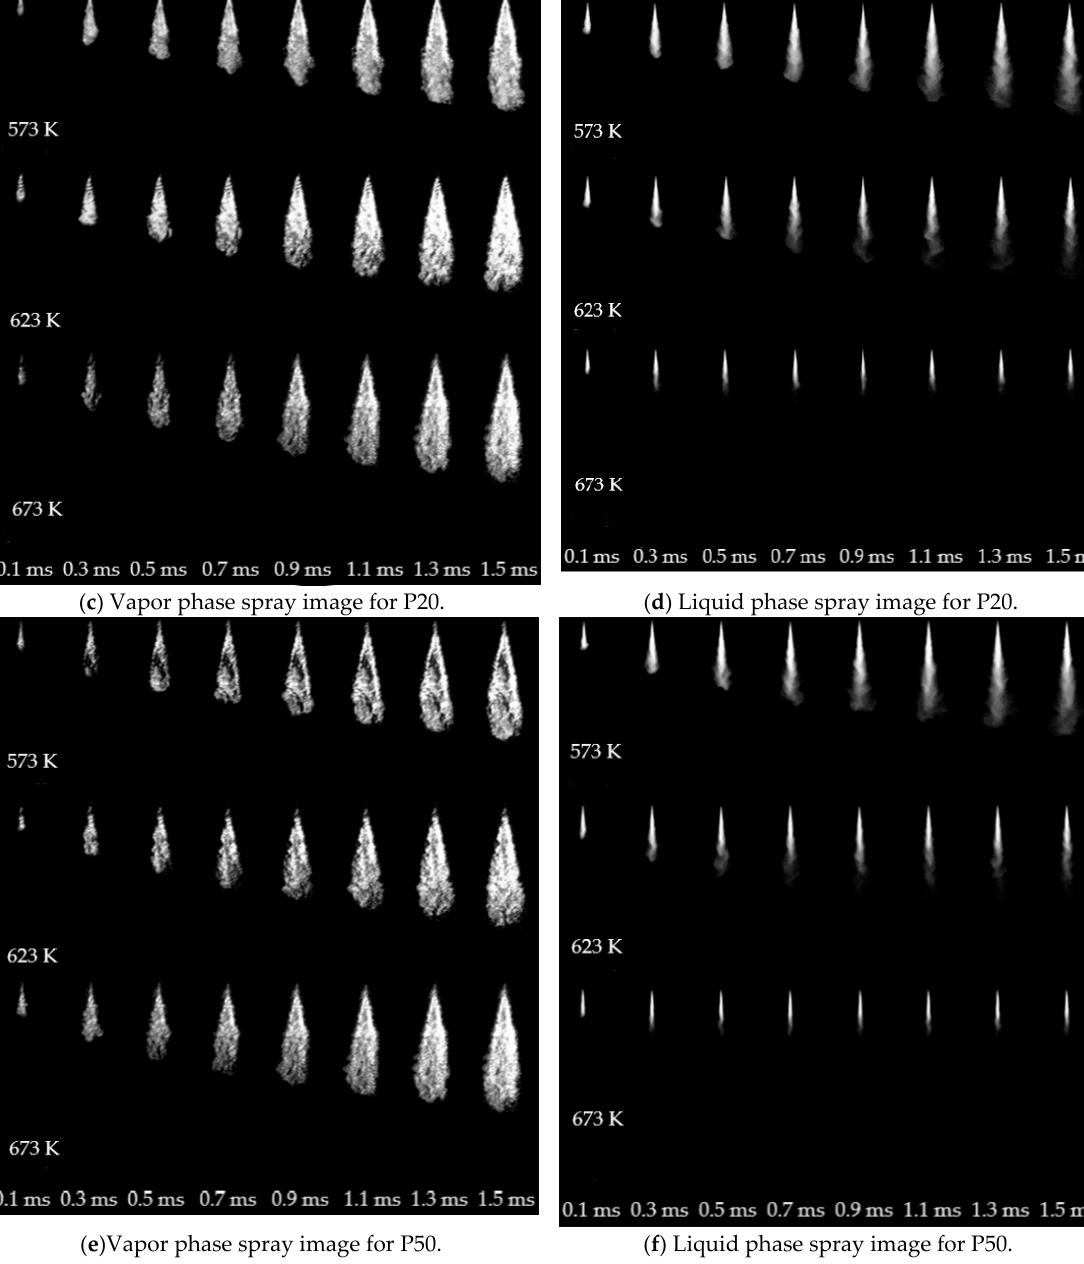
Figure 6. Spray development for different blends at different ambient temperatures.